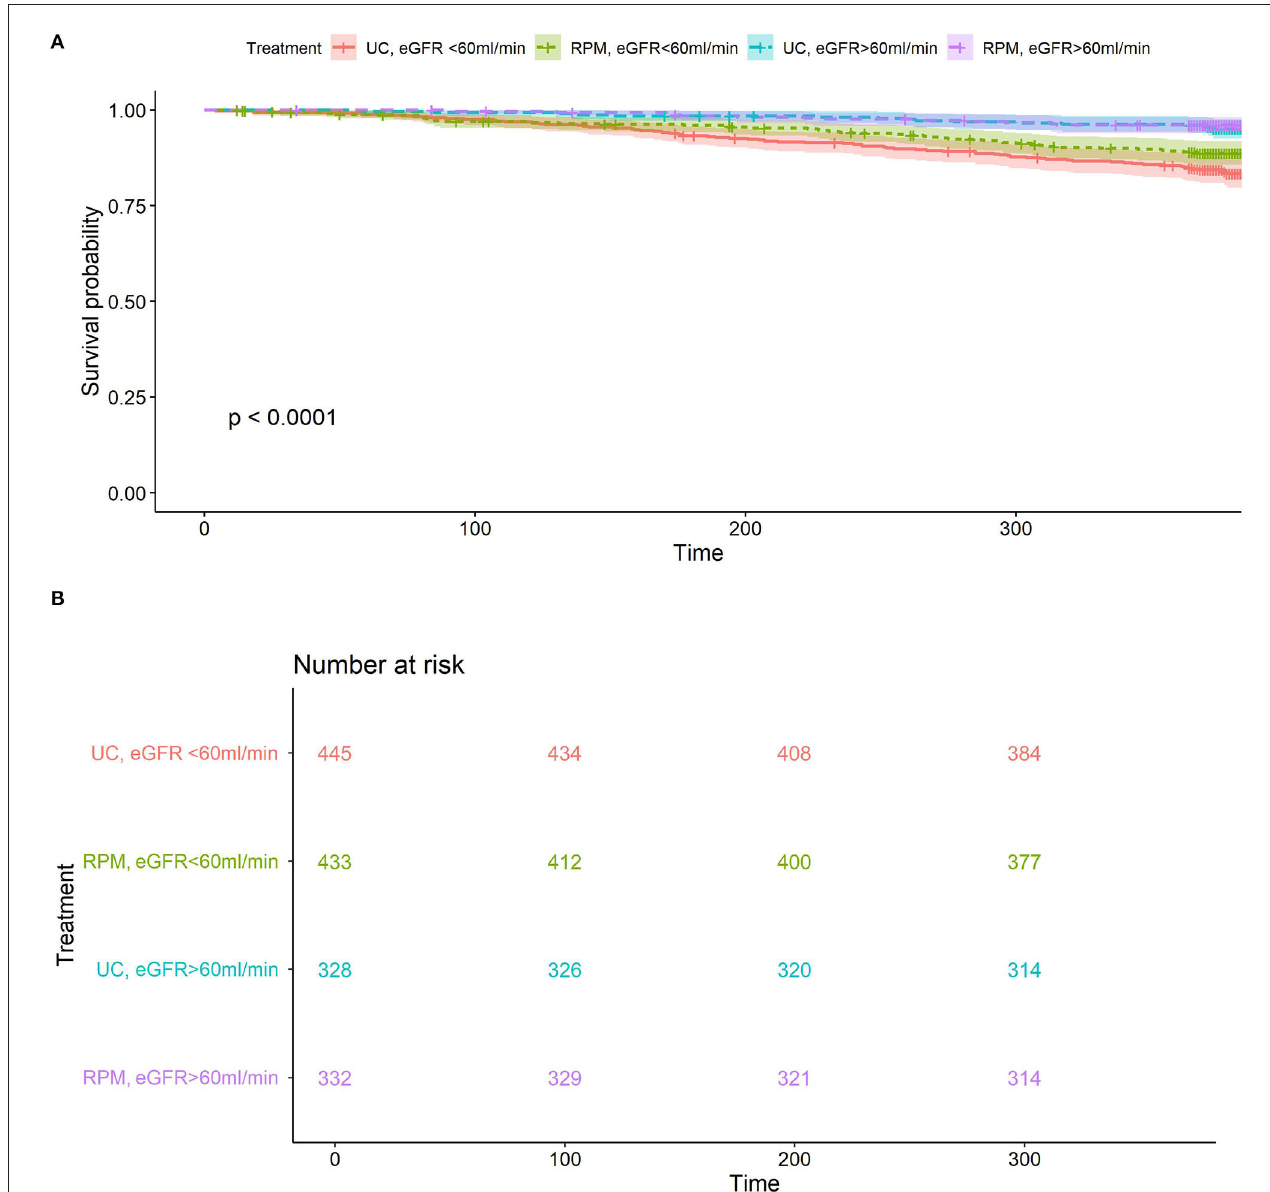
FIGURE 2 | (A) All-cause mortality according to randomization arm and renal function. Overall p < 0.001, for eGFR subgroup < 60 ml/min/1.73 m ² p = 0.037 RPM (green) vs. UC (red), eGFR subgroup ≥ 60 ml/min/1.73 m ² , p = 0.7 RPM (purple) vs. UC (blue). (B) Number at risk for all-cause mortality according to randomization arm and renal function: eGFR subgroup < 60 ml/min/1.73 m ² , p = 0.037 RPM (green) vs. UC (red), eGFR subgroup ≥ 60 ml/min/1.73 m ² , p = 0.7 RPM (purple) vs. UC